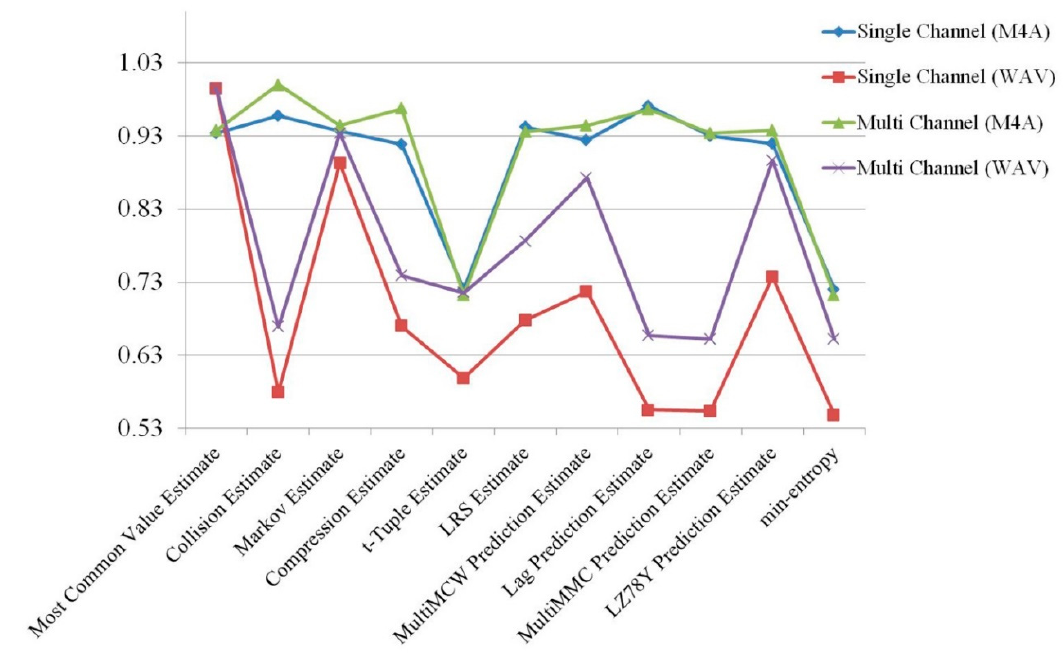
Figure 4. Randomness estimation results comparing single and multiple channels.